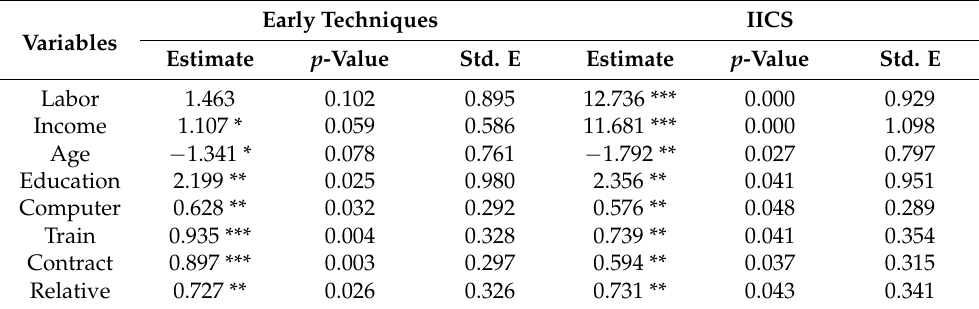
Table 3. Estimation